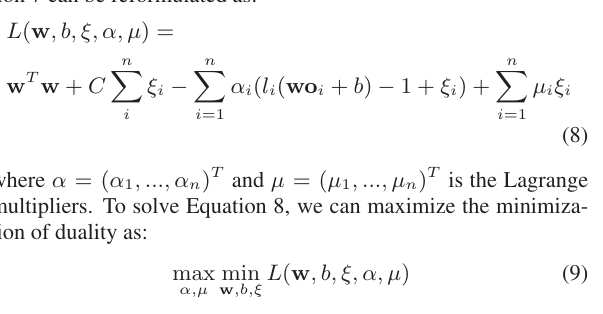
Figure 7: Comparison on traditional GMM with DPGMM over two dimensional